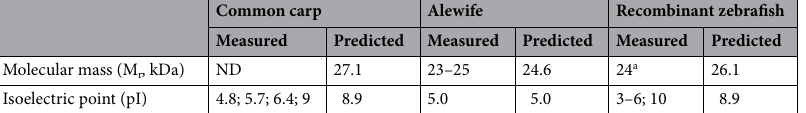
Table 2. Comparison of measured biochemical characteristics of thiaminases with predictions from candidate gene sequences from common carp ( Cyprinus carpio , XP_042594753), alewife ( Alosa pseudoharengus , AleC120, Supplementary Fig. 2), and zebrafish ( Danio rerio , NP_001314821). a By non-denaturing sodium dodecyl sulfate polyacrylamide gel electrophoresis